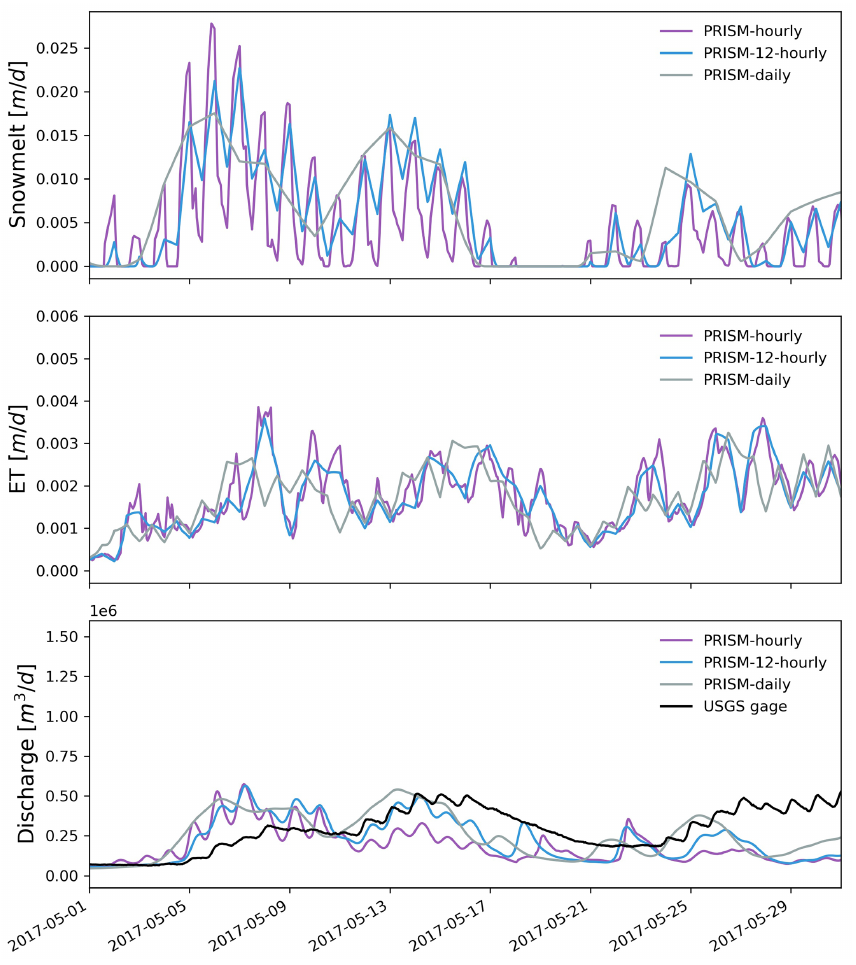
Figure 15. Zoomed-in plots showing hourly simulated snowmelt, ET, and discharge under different temporal resolutions of PRISM in May